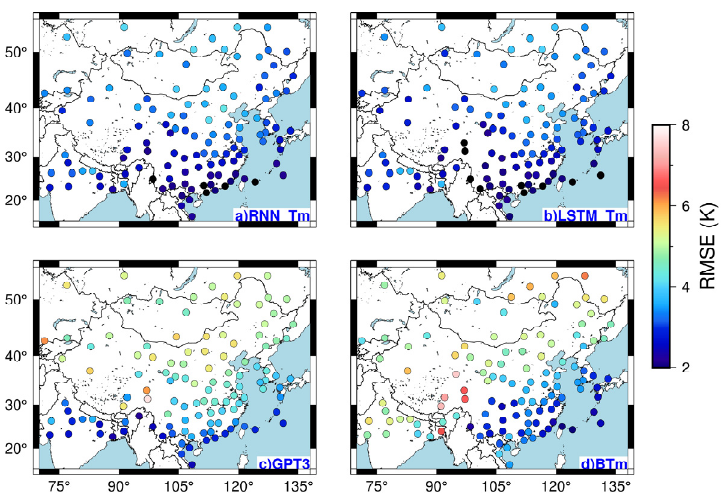
Figure 7. RMSE distribution of the four models at each radiosonde station. ( a ) RNN_Tm, ( b ) LSTM_Tm, ( c ) GPT3, and ( d ) BTm models.